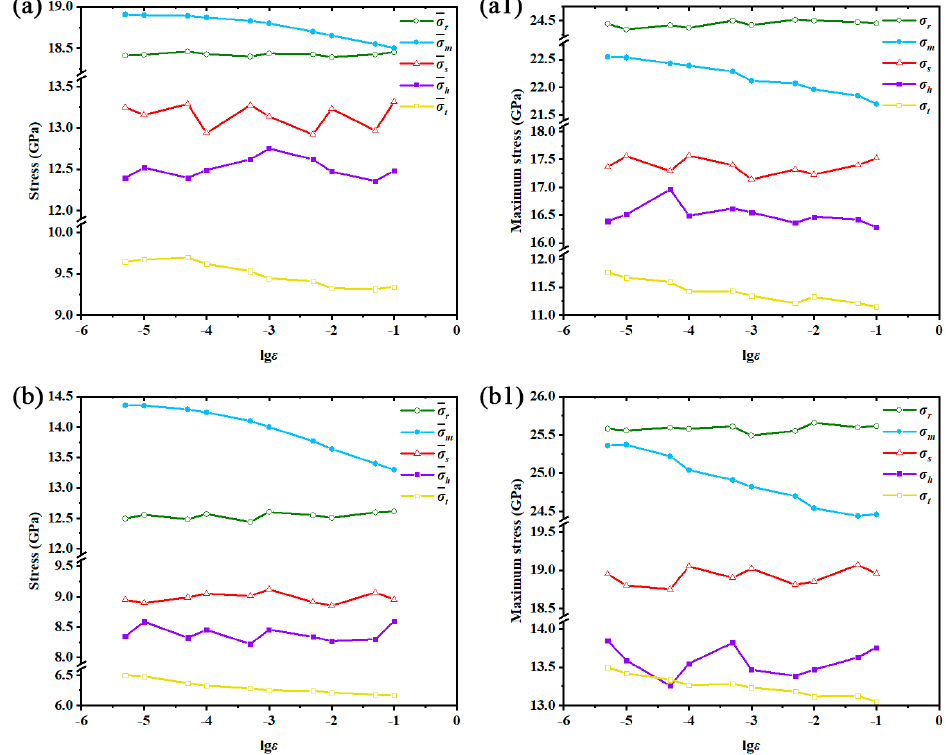
Figure 7. lg ε versus five equivalent stresses: ( a ) average stress level of Mono-Si; ( a1 ) maximum stress level of Mono-Si; ( b ) average stress level of SiNW; ( b1 ) maximum stress level of SiNW.